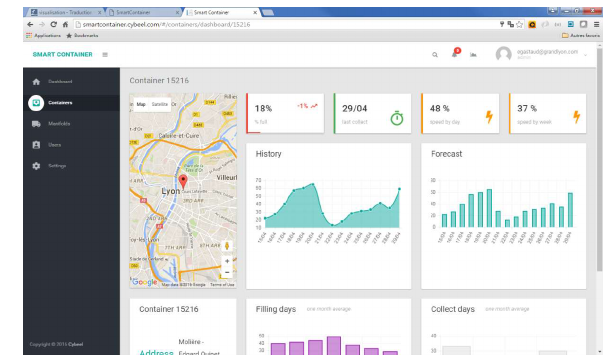
Figure 14. Example of a bottle banks dashboard – Proof of concept of